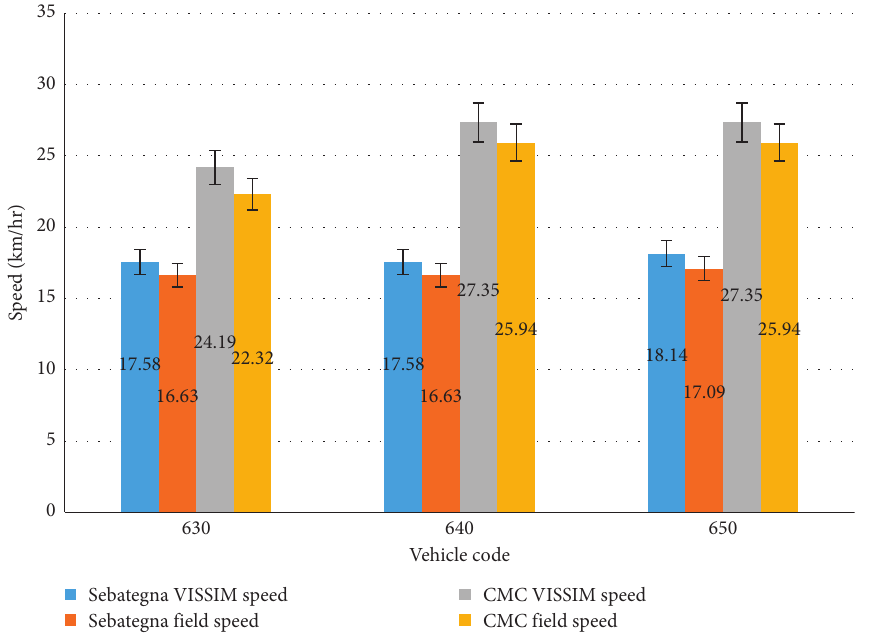
Figure 5: CMC and Sebategna level crossing speed